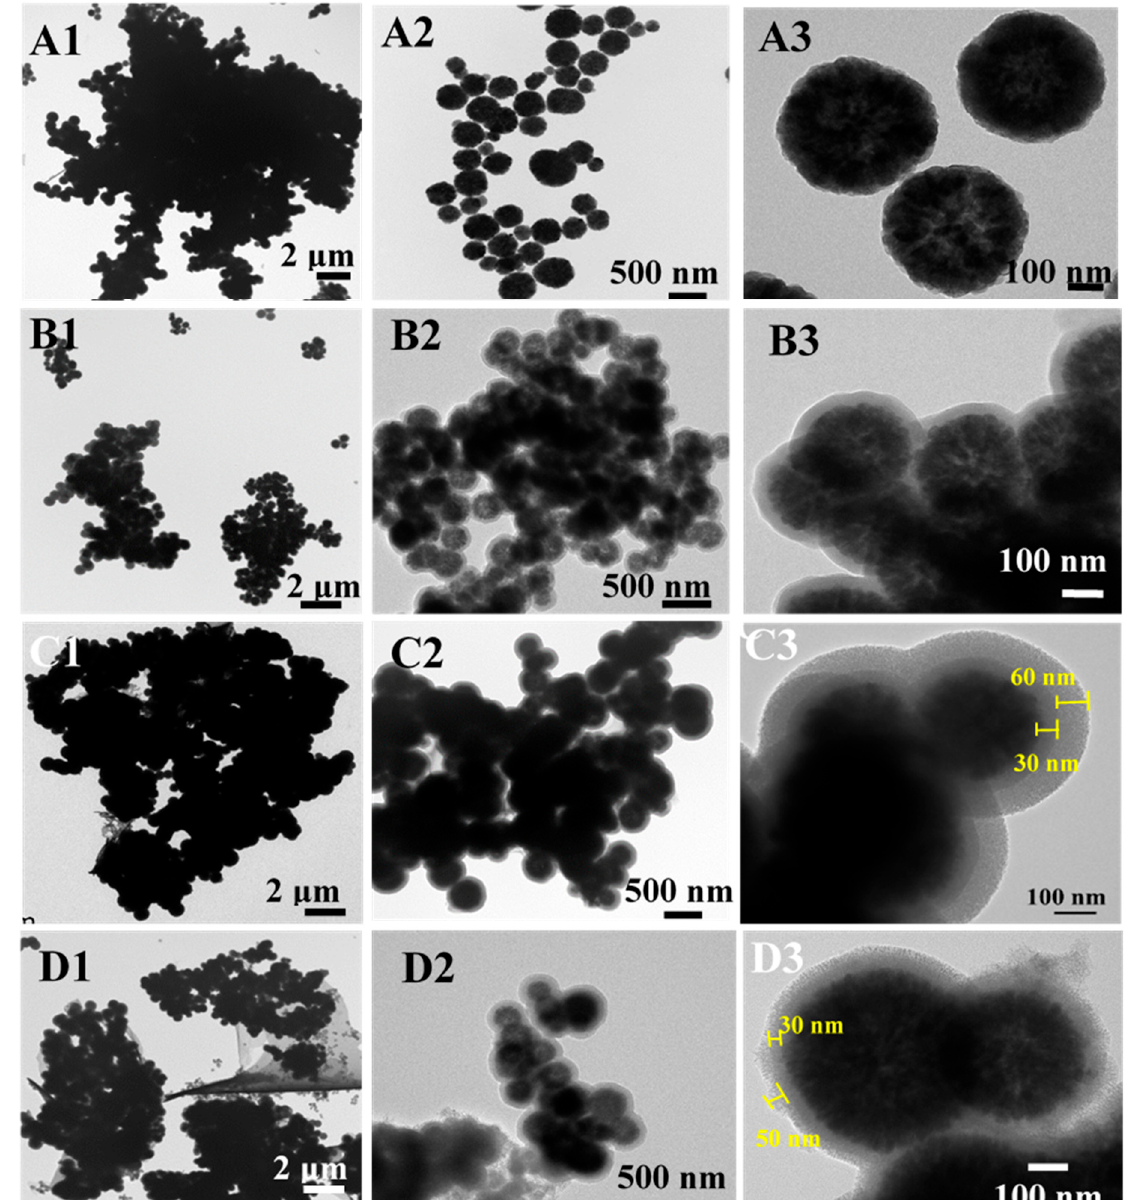
Figure 3. TEM image ( A )Fe 3 O 4 ; ( B ) Fe 3 O 4 @SiO 2 ; ( C )m-NI-MSNPs; ( D )m-DMI-MSNPs. The FT-IR spectra of the Fe 3 O 4 , Fe 3 O 4 @SiO 2 , m-DMI-MSNPs, and m-NI-MSNPs are